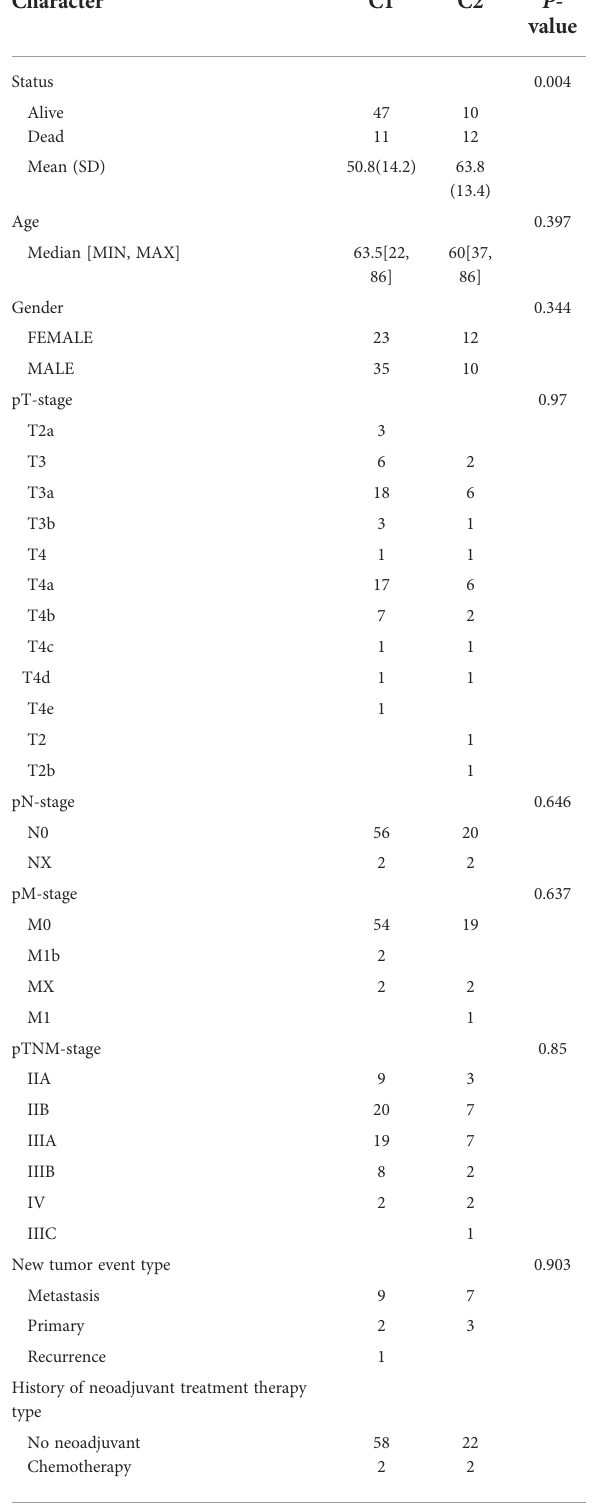
TABLE 2 Comparison of clinical data between